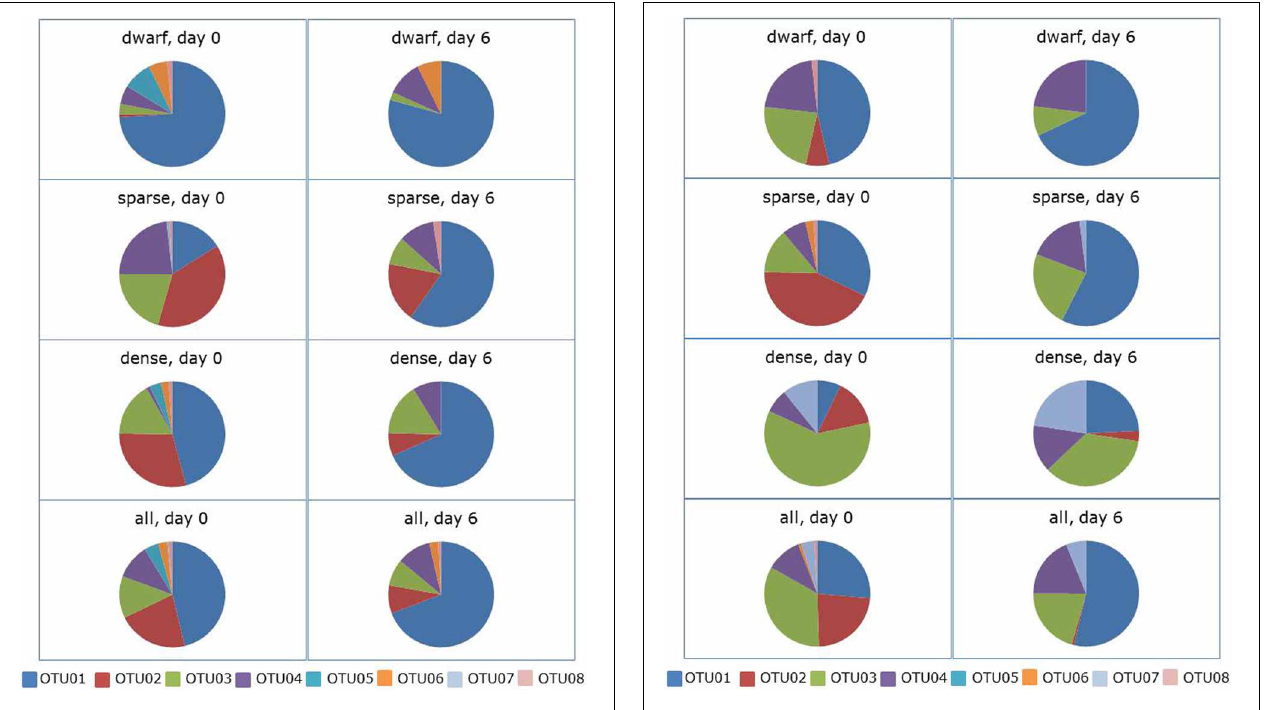
FIGURE 2 | Effect of 6 days of ammonium enrichment on the sequence distribution of ammonia-oxidizing betaproteobacteria in non-shaken soil slurries. Sequences originated from different vegetation cover types of Avicennia germinans forests sampled in 2009. Operational Taxonomic Units (OTUs) are based on the partial 16S rRNA gene (440bp).